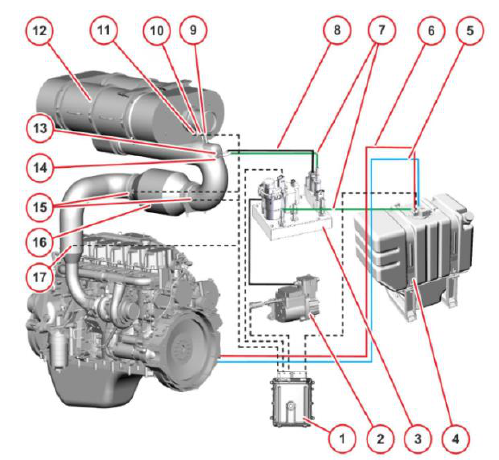
Fig. 15. Exhaust aftertreatment system: 1 – engine control module, 2 – SCR compressor, 3 – SCR pump, 4 – SCR tank, 5 – coolant line, dis- penser, 6 – pre-heating line, SCR tank, 7 – SCR line, 8 – AdBlue ® injec- tion air supply line, 9 – NH 3 sensor, 10 – NO x sensor, 11 –